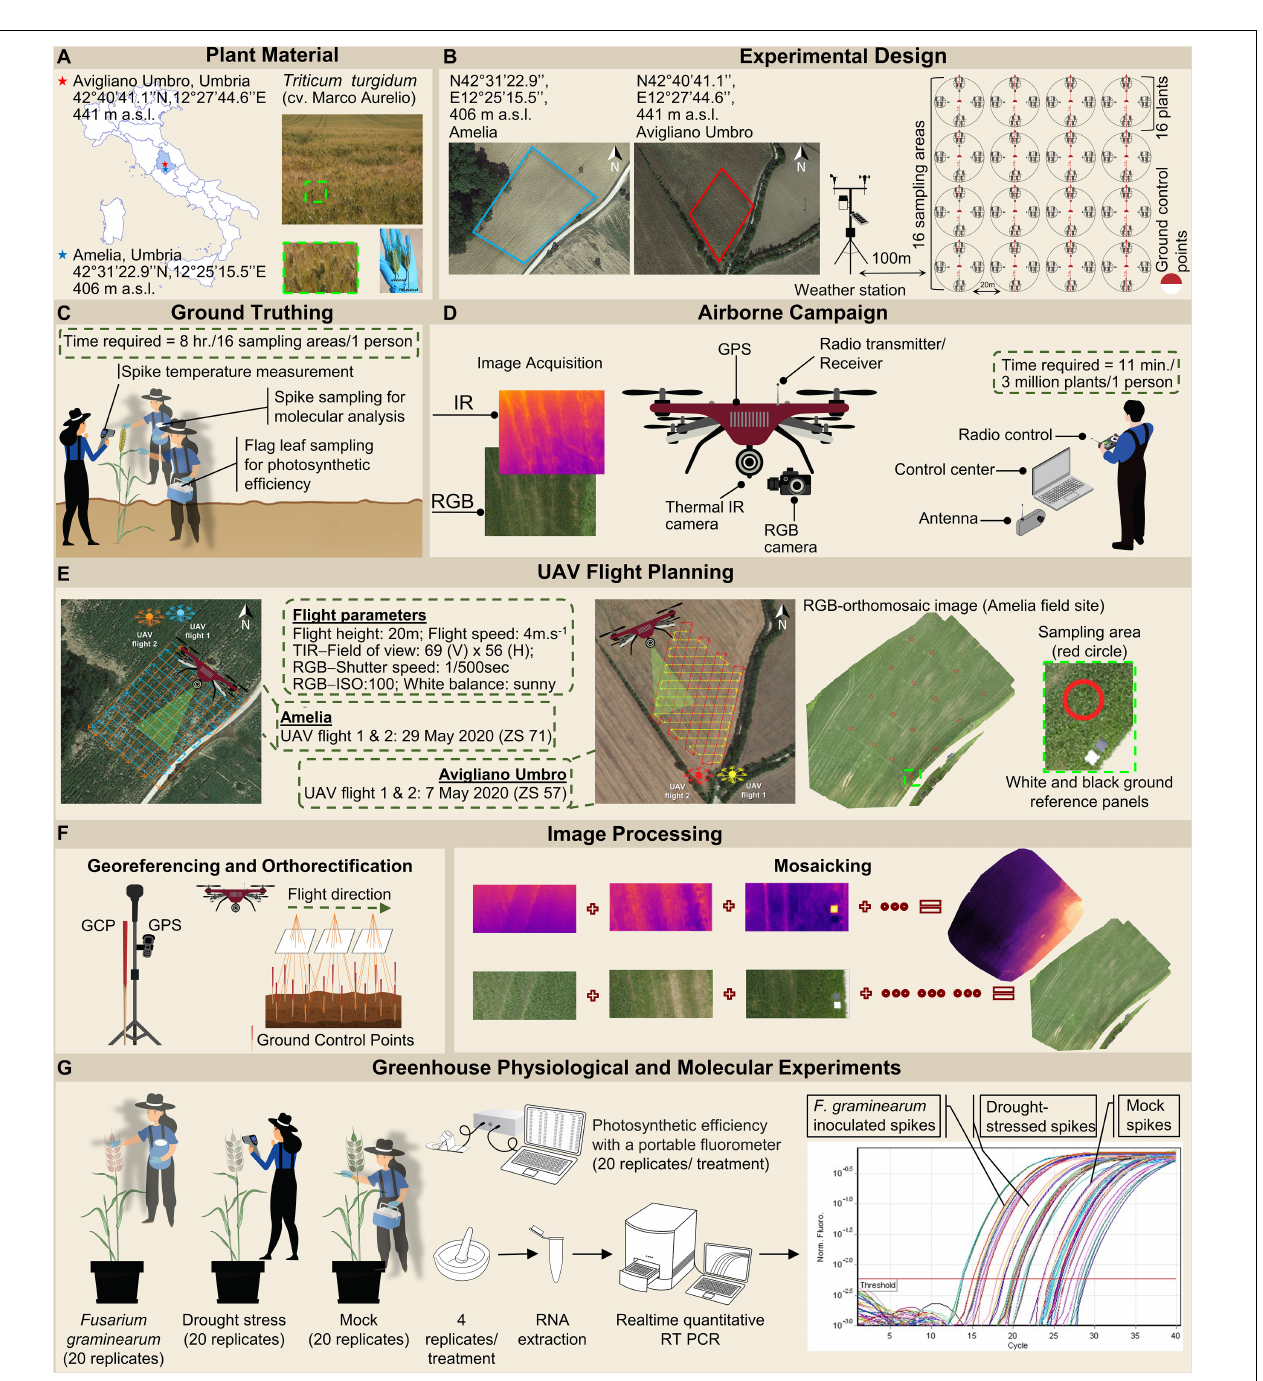
FIGURE 1 | Workflow of the high-throughput field phenotyping methodology and the greenhouse experiment. (A) Plant material includes Triticum turgidum (cv. Marco Aurelio). Two fields were established in Amelia (Central Italy, 42 ◦ 31 (cid:48) 22.9 (cid:48)(cid:48) N, 12 ◦ 25 (cid:48) 15.5 (cid:48)(cid:48) E, Umbria Region, 406 m above sea level) and Avigliano Umbro (Central Italy, 42 ◦ 40 (cid:48) 41.1 (cid:48)(cid:48) N, 12 ◦ 27 (cid:48) 44.6 (cid:48)(cid:48) E, Umbria Region, 441 m a.s.l) to host the T. turgidum plants. Sampled spikes show the symptoms of a Fusarium head blight (FHB)-infected plant, compared to an uninfected plant. (B) An experimental plot was allocated within each field, and a 20 m grid was identified by positioning sixteen ground control points (GCPs) to be used for georeferencing. Around each of the GCPs, a circumference of 1 m of diameter was individuated and denominated as a sampling area. Weather data were recorded daily by two meteorological stations installed at 100 m distance from each field. (C) Within each sampling area, the spike temperature of sixteen randomly selected spikes was measured, and their flag leaves were sampled to measure their photosynthetic efficiency. Finally, the spikes were also sampled to distinguish FHB positive (FHB+) ones from FHB negative (FHB-) ones by molecular identification of Fusarium spp. (D) An unmanned DJI Matrice 600 hexacopter was equipped with Zenmuse X5 red-green-blue (RGB) and Zenmuse XT thermal infrared (TIR) sensors.